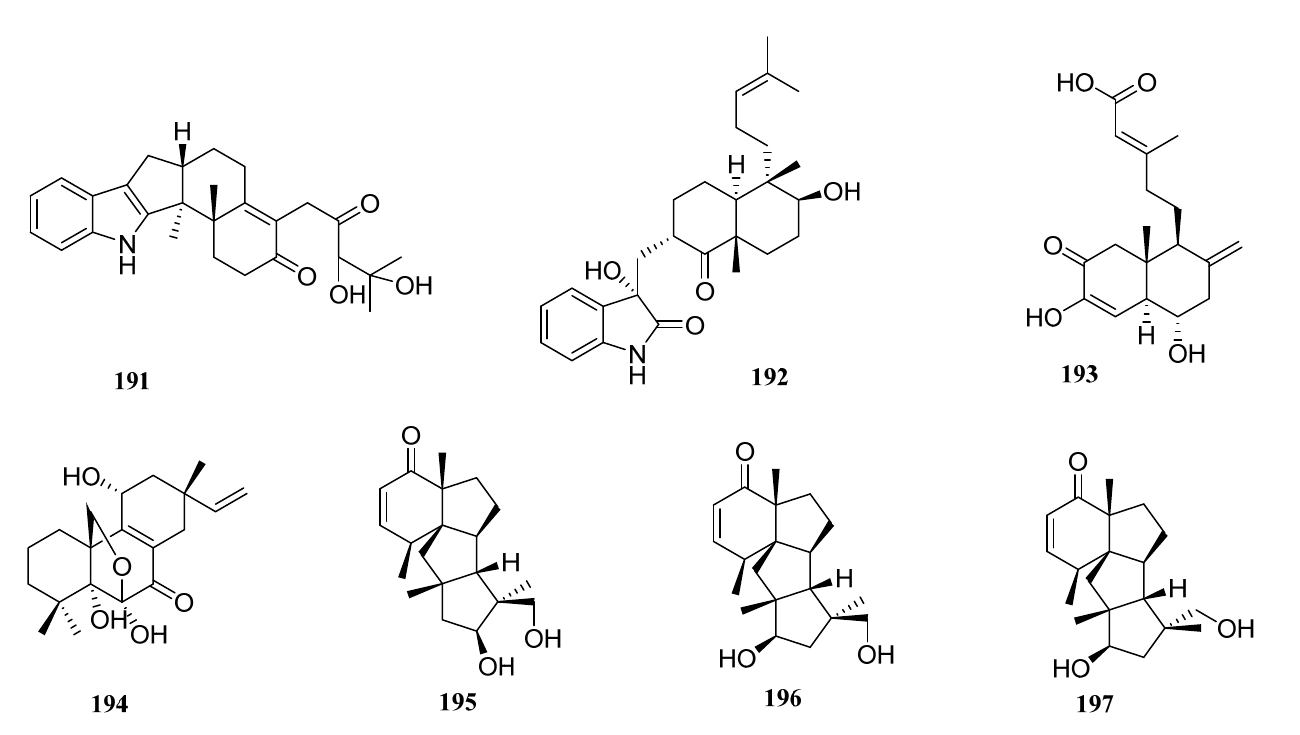
Figure 8. Chemical structures of diterpenes ( 152 from Neosartorya sp., 153 – 197 from Penicillium sp.).